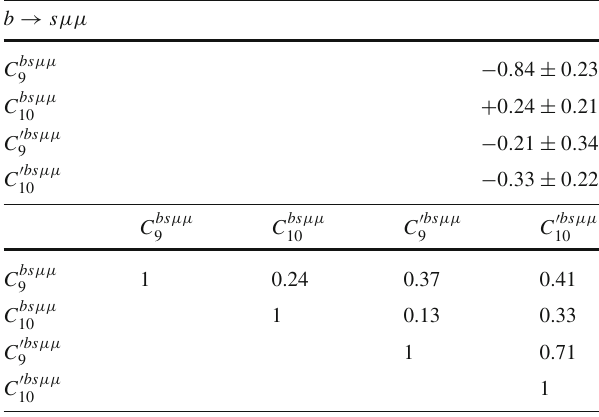
Table 4 Best fit values, uncertainties, and correlation matrix of the four-parameter fit to the Wilson coefficients C bs